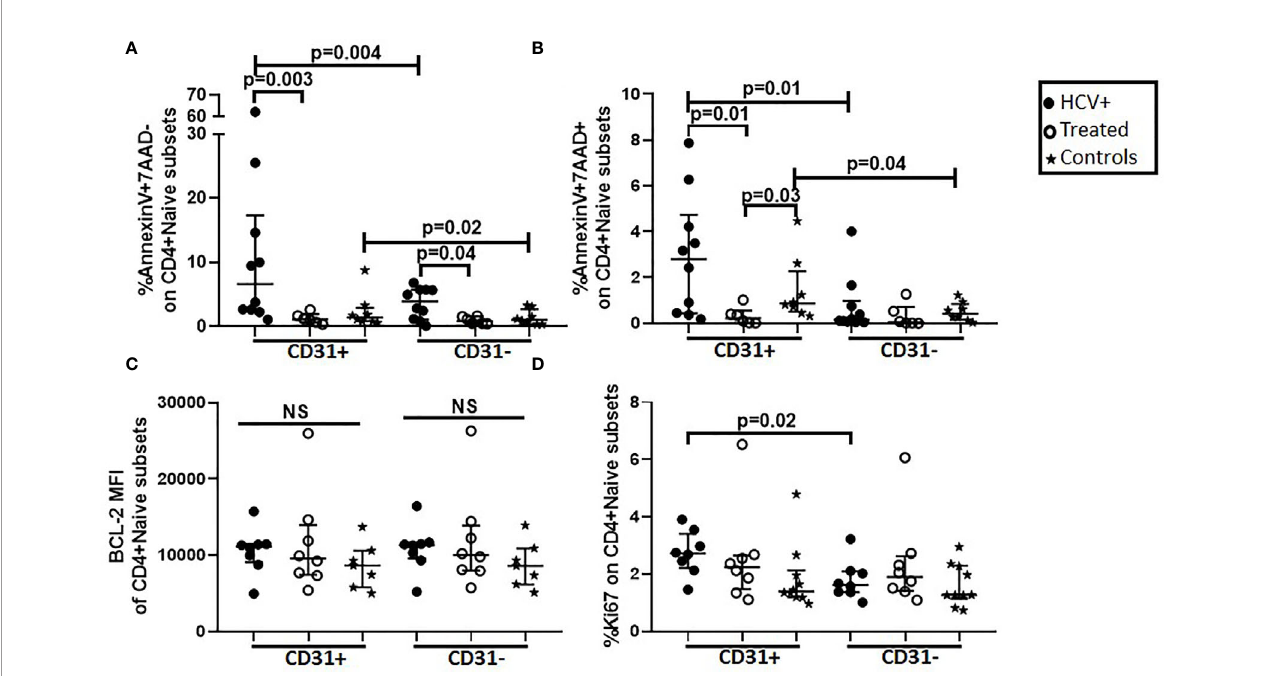
FIGURE 3 | Direct ex vivo apoptosis in CD31+ and CD31- naïve CD4+ T cell subsets is greater in HCV infected individuals compared to HCV DAA-treated individuals and uninfected controls and the CD4+CD31+ subset exhibits greater ex vivo apoptosis and cell cycling (Ki67 expression) compared to the CD4+CD31- subset. Magnetic bead puri fi ed (negative selection) naïve CD4 T cells from chronic HCV infected ( fi lled circles, n=8), HCV DAA-treated (open circles, n=8) and age- range matched uninfected control (stars, n=7) groups were analyzed by fl ow cytometry for apoptosis (AnnexinV and 7AAD) (A, B) , BCL-2 (C) and cell cycling (Ki67) (D) on naïve (CD27+CD45RA+) CD4+CD31+ and CD4+CD31- T cells. Mann Whitney test was used for comparisons between two groups and between the CD4+CD31+ and CD4+CD31- subsets; p= <0.05 considered signi fi cant. NS represents non-signi fi cant p